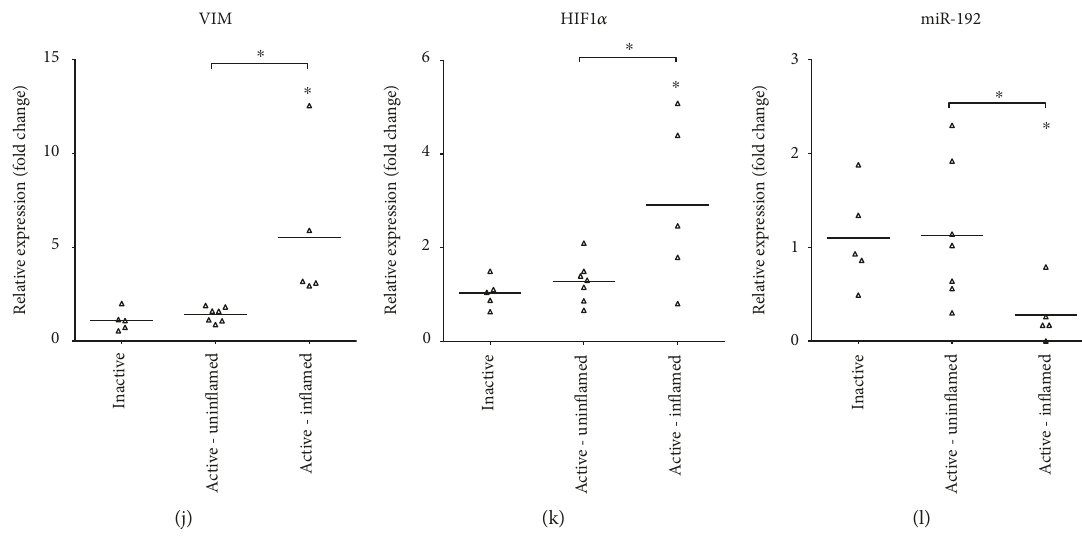
Figure 2: Distinct expression of genes and microRNA regulating epithelial-to-mesenchymal transition in IBD patients. The relative gene expression of TAM receptors TYRO3 (a), AXL (b), and MERTK (c); their receptors GAS6 (d) and PROS1 (e); and genes involved in epithelial-to-mesenchymal transition SNAI1 (f), ZEB2 (g), MMP9 (h), CDH1 (i), VIM (j), and HIF1 α (k) as well as microRNA miR-192 (l) are shown from inactive (left, n = 5 ), active-unin fl amed (middle, n = 7 ), and active-in fl amed (right, n = 5 ) colon samples of IBD patients. Dots and lines represent individual values and the mean, respectively; ∗ p < 0 05